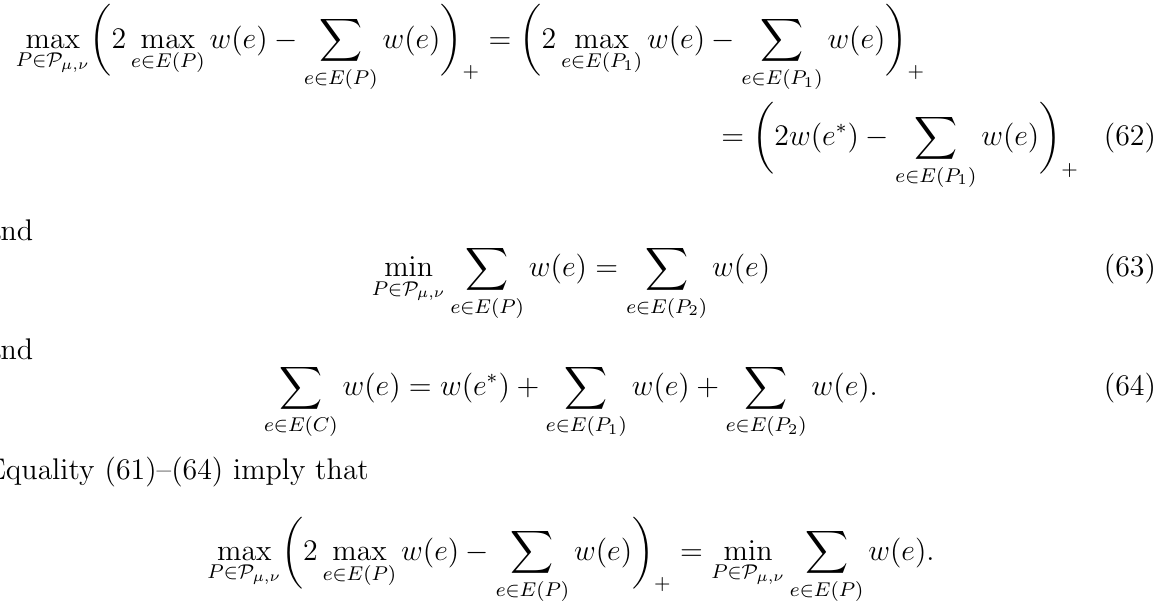
= µ and v 1 } , P = ( v , v , v , v ) and P 7 1 1 2 3 4